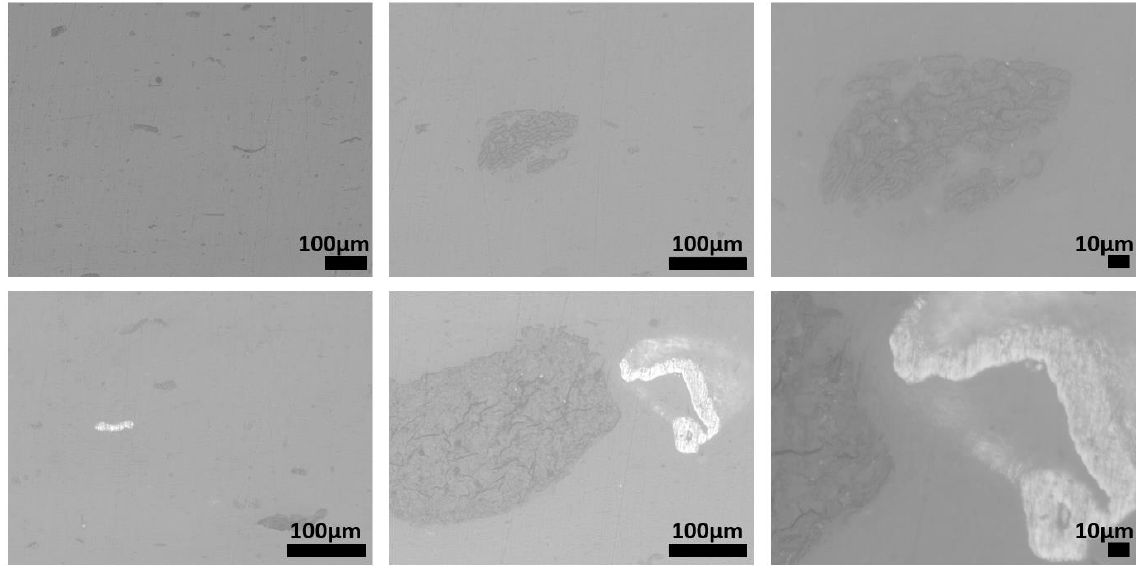
Figure 10. Microstructure of specimens produced by using recovered PET.